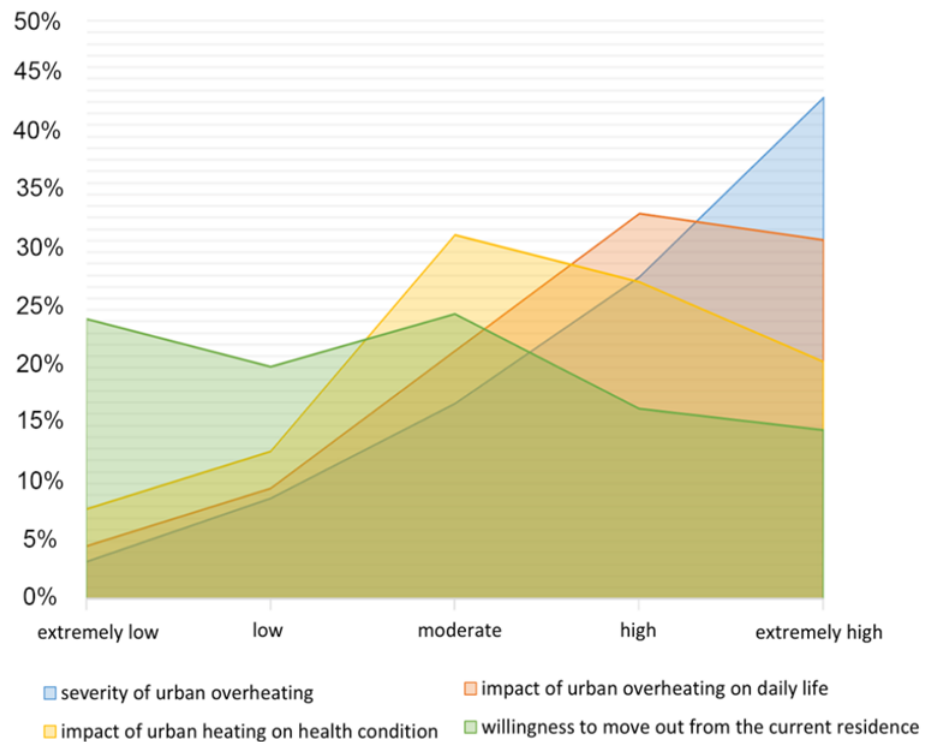
Figure 13. Public views on urban heat island impacts.